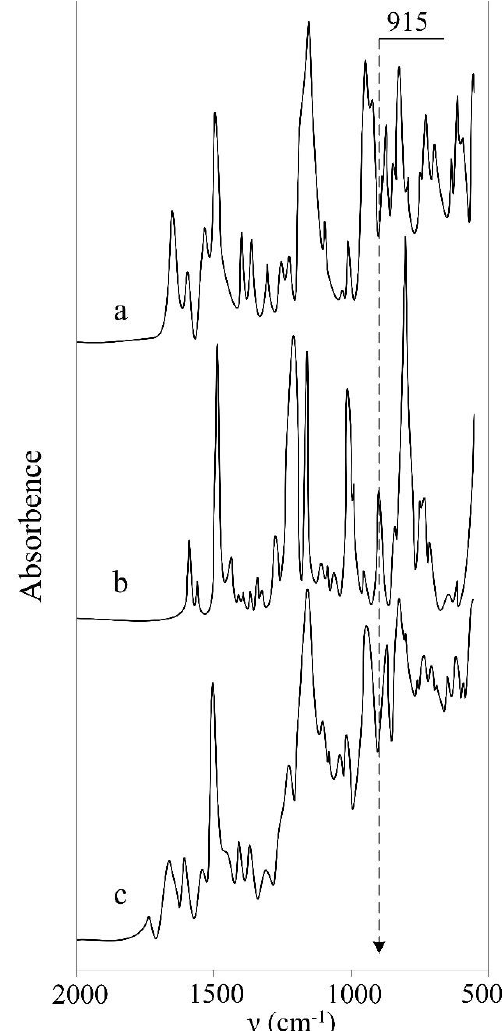
Figure 6. IR spectra of ( a ) ACP, ( b ) DER-331, and ( c ) cured composition.